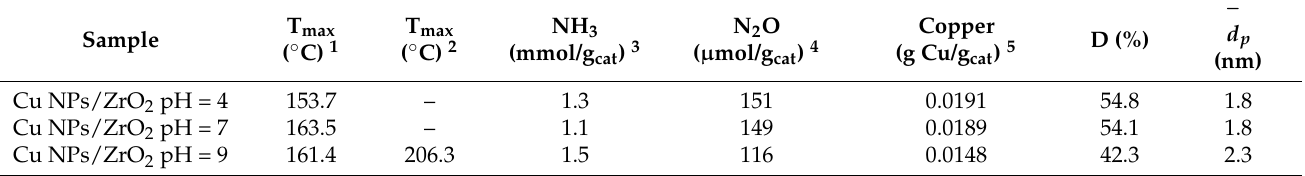
Figure 3. TPR analysis. ( 1 ) Cu NPs/ZrO 2 pH = 4, ( 2 ) Cu NPs/ZrO 2 pH = 7, ( 3 ) Cu NPs/ZrO 2 pH = 9. Table 2. Adsorption properties, exposed copper atoms and dispersion of copper